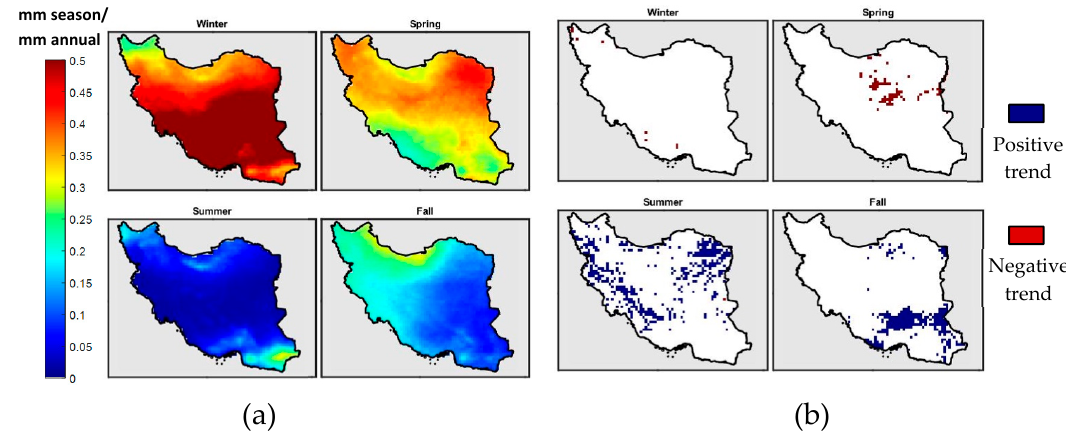
Figure 4. ( a ) Spatial contribution map for each season to annual precipitation based on the climate data record of PERSIANN-CDR for the period 1983 to 2018; ( b ) spatial map for trend of the contribution of each season to annual precipitation.